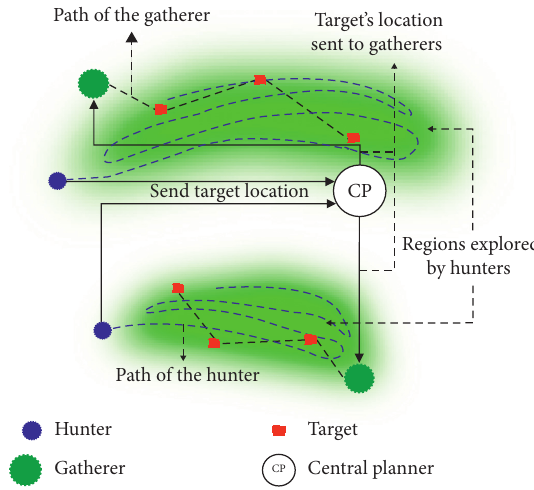
Figure 1: A schematic model of the system showing how the hunters and gatherers perform their respective operations while being assisted by a Central Planner